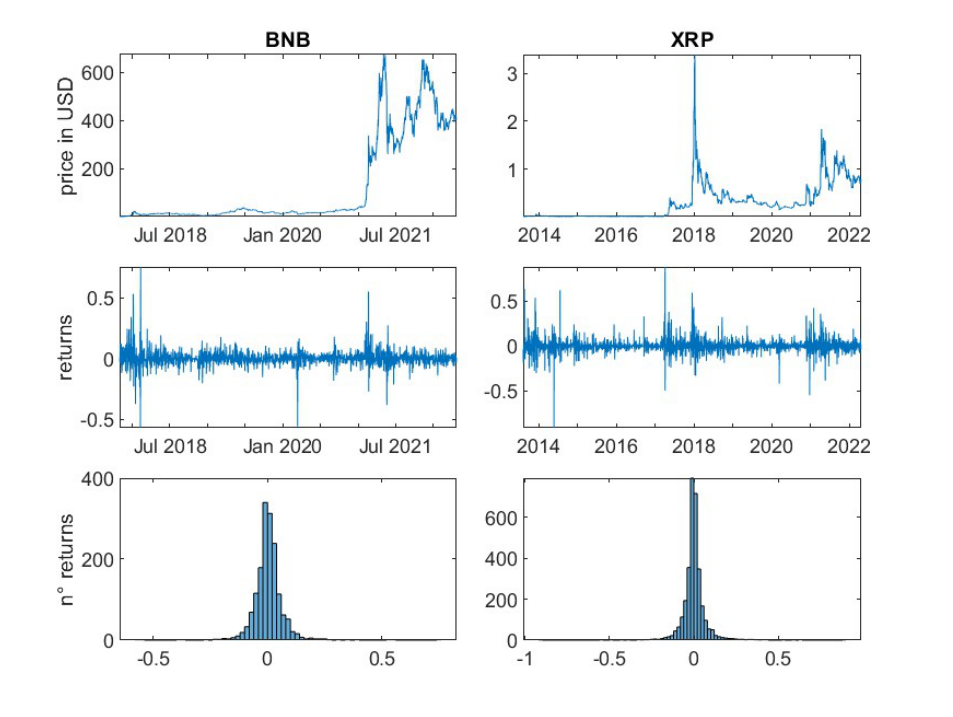
Figure A2. BNB and XRP daily logarithmic returns.